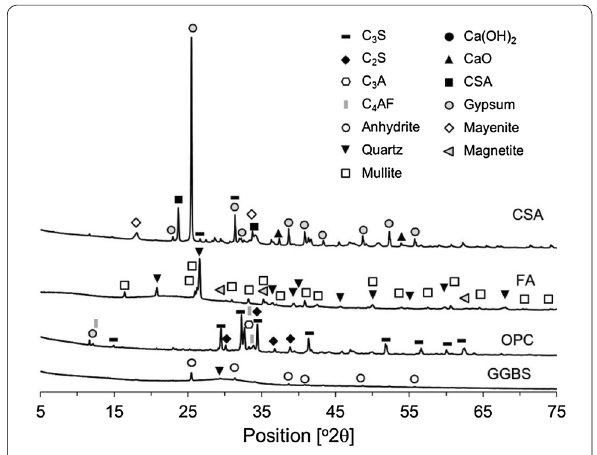
Fig. 1 XRD pattern of used raw materials.